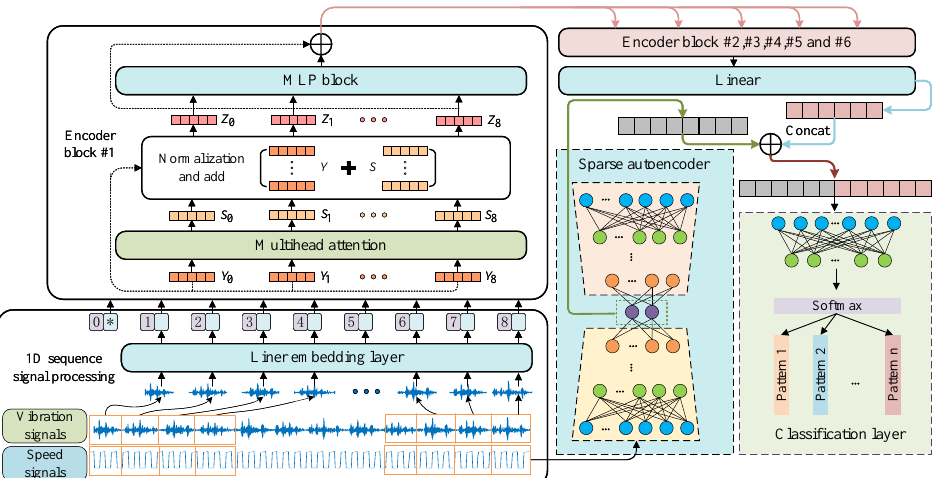
Figure 2. The framework of